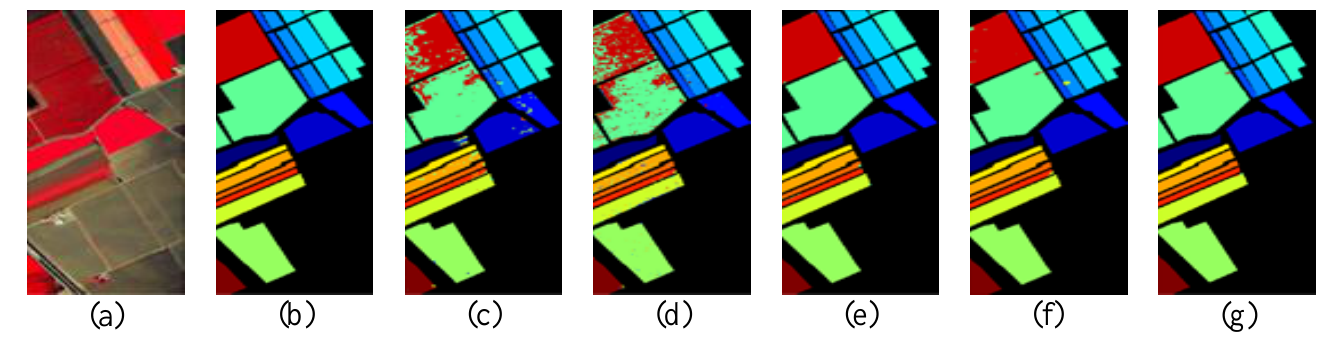
Figure 9. ( a ) False-color composite (R: 53, G: 31, B: 8), ( b ) Ground truth, ( c ) SS-3DCNN (98.29%), ( d ) SSAF-DCR (96.53%), ( e ) DSSIRNet (99.35%), ( f ) C-CNN (99.22%), ( g ) C-CNN-Aug